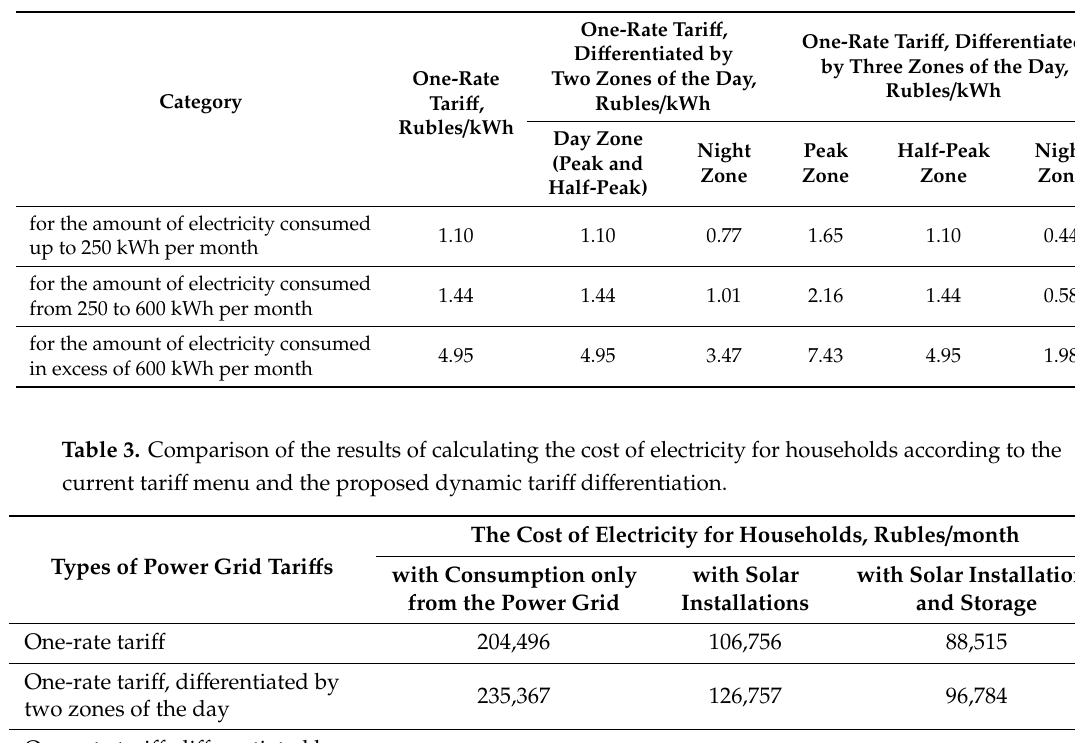
Table 2. Electricity tari ff s in the Krasnodar region.